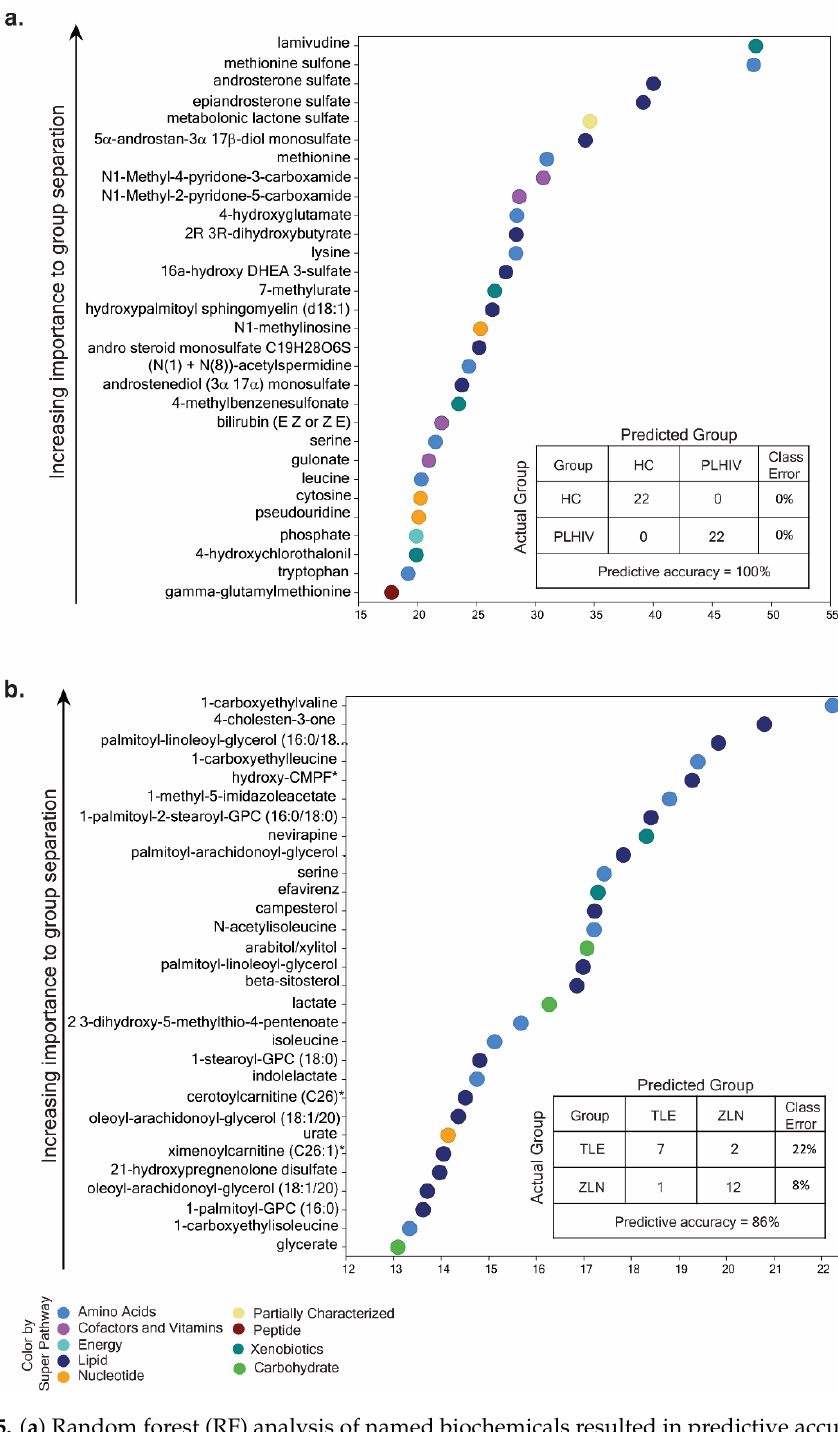
Figure 5. ( a ) Random forest (RF) analysis of named biochemicals resulted in predictive accuracies of 100% for HC vs. PLHIV. The biochemical importance plots display the top 30 metabolites which most strongly contribute to the groups’ separation for HC vs. PLHIV based on amino-acid metabolism, lipid metabolism, energy metabolism, co-factors and vitamins, peptides, and xenobiotics, as indicated in different colors in the legend. ( b ) The RF analysis of named biochemicals resulted in predictive accuracies of 86% for PLHIV-TLE vs. PLHIV-ZLN. The biochemical importance plots display the top 30 metabolites which most strongly contribute to the groups’ separation based on amino-acid metabolism, carbohydrate metabolism, lipid metabolism, nucleotide metabolism, and xenobiotics.